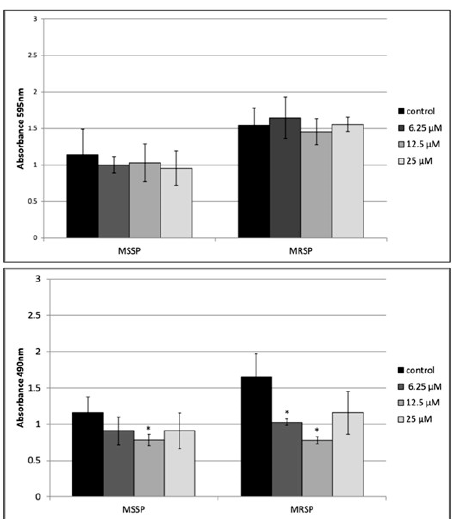
Figure 3. Peptide 8 activity on MSSP and MRSP mature biofilm assessed by crystal violet assay (upper panel) and XTT assay (bottom panel) Experiments were performed in triplicate in three independent experiments. * p < 0.05.